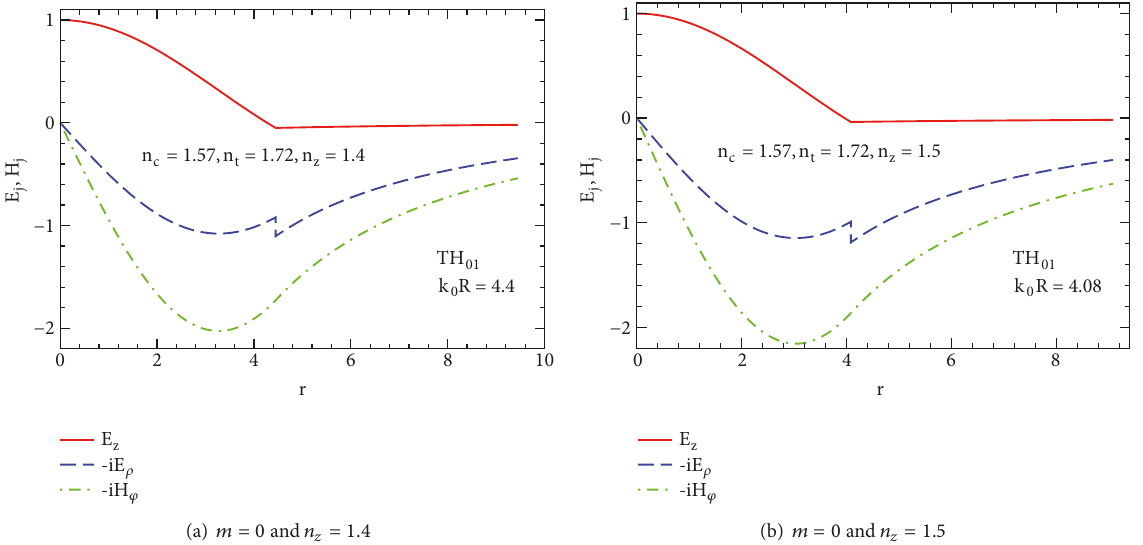
Figure 2: Electromagnetic field versus the dimensionless radial parameter 𝑟 = 𝑘 0 𝜌 for the mode TH 01 ( 𝐻 𝑧 = 0 ) at (a) 𝑛 𝑧 = 1.4 and (b) 𝑛 = 1.5 𝑧